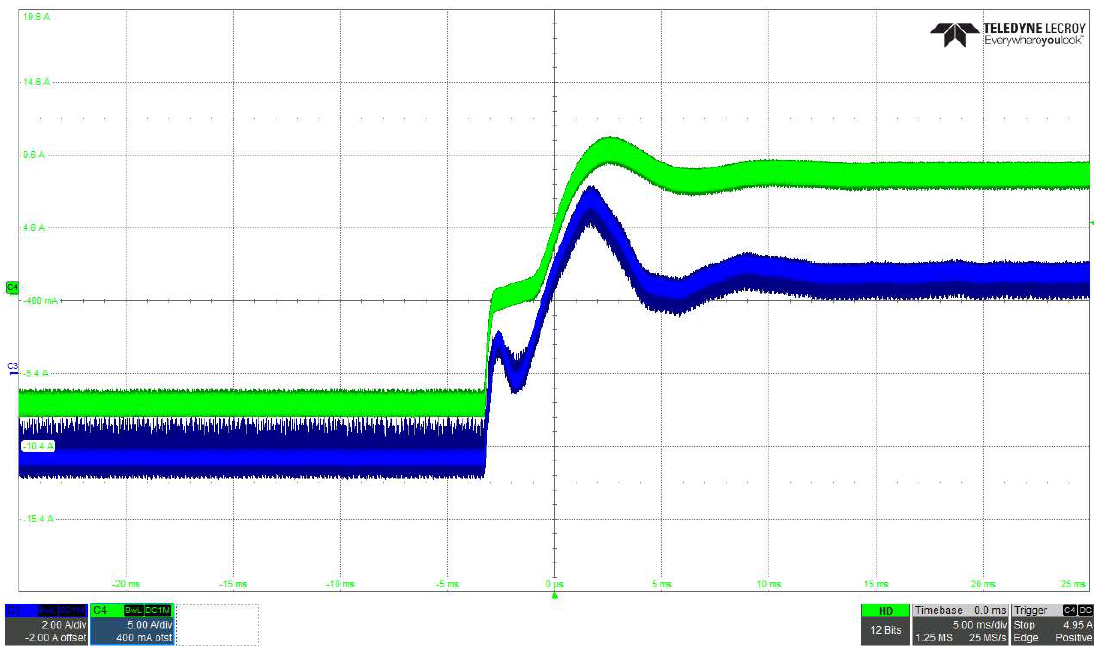
Figure 29. Experimental BHSC waveforms. Transition from step-up operation at −10 A to step-down operation at +10 A. Operating conditions: V H = 100 V, V L = 50 V, I L1 = (+/−)10A (controlled), I L2 = 3.75A. C3: i L2 ; C4: i L1 .